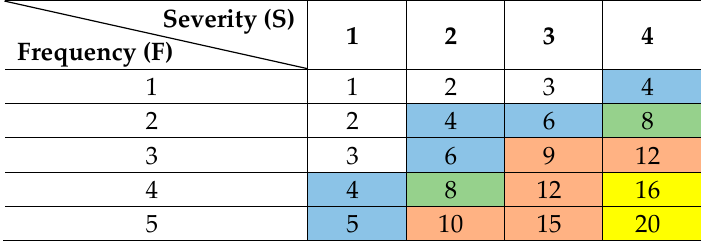
Table 3. Extraction of fall hazard from disaster scenario. 13